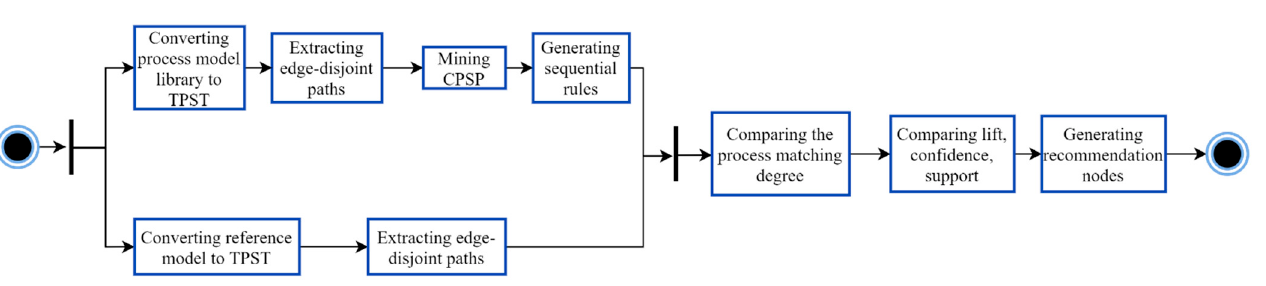
Figure 2. The basic flow of the proposed method as represented using a UML activity diagram.